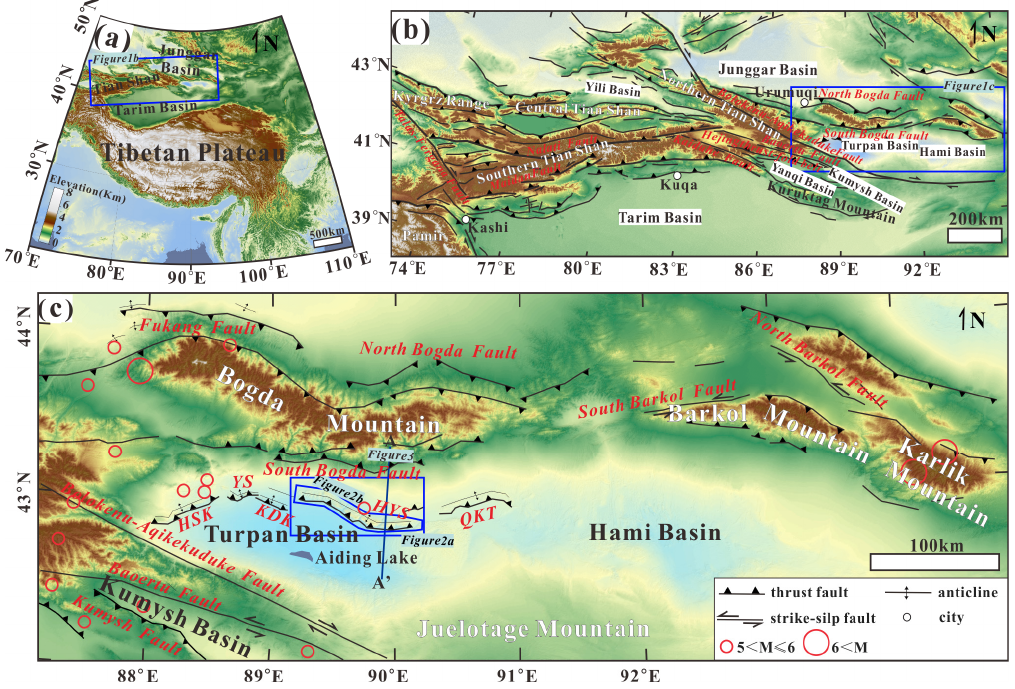
Figure 1. ( a ) Topography of the Tian Shan, showing its location and geological setting. The blue box shows the location of ( b ). ( b ) Simplified tectonic map showing major active structures in the Tian Shan. The blue box shows the location of ( c ). ( c ) Simplified tectonic map of the eastern Chinese Tian Shan. Faults are modified by Deng et al. [37] and Wu et al. [58]. Red hollow circles indicate earth- quake's magnitude (Mw or mb) since 1900 (earthquake data are downloaded from https://earth- quake.usgs.gov/earthquakes/search/ (accessed on 22 September 2022)).